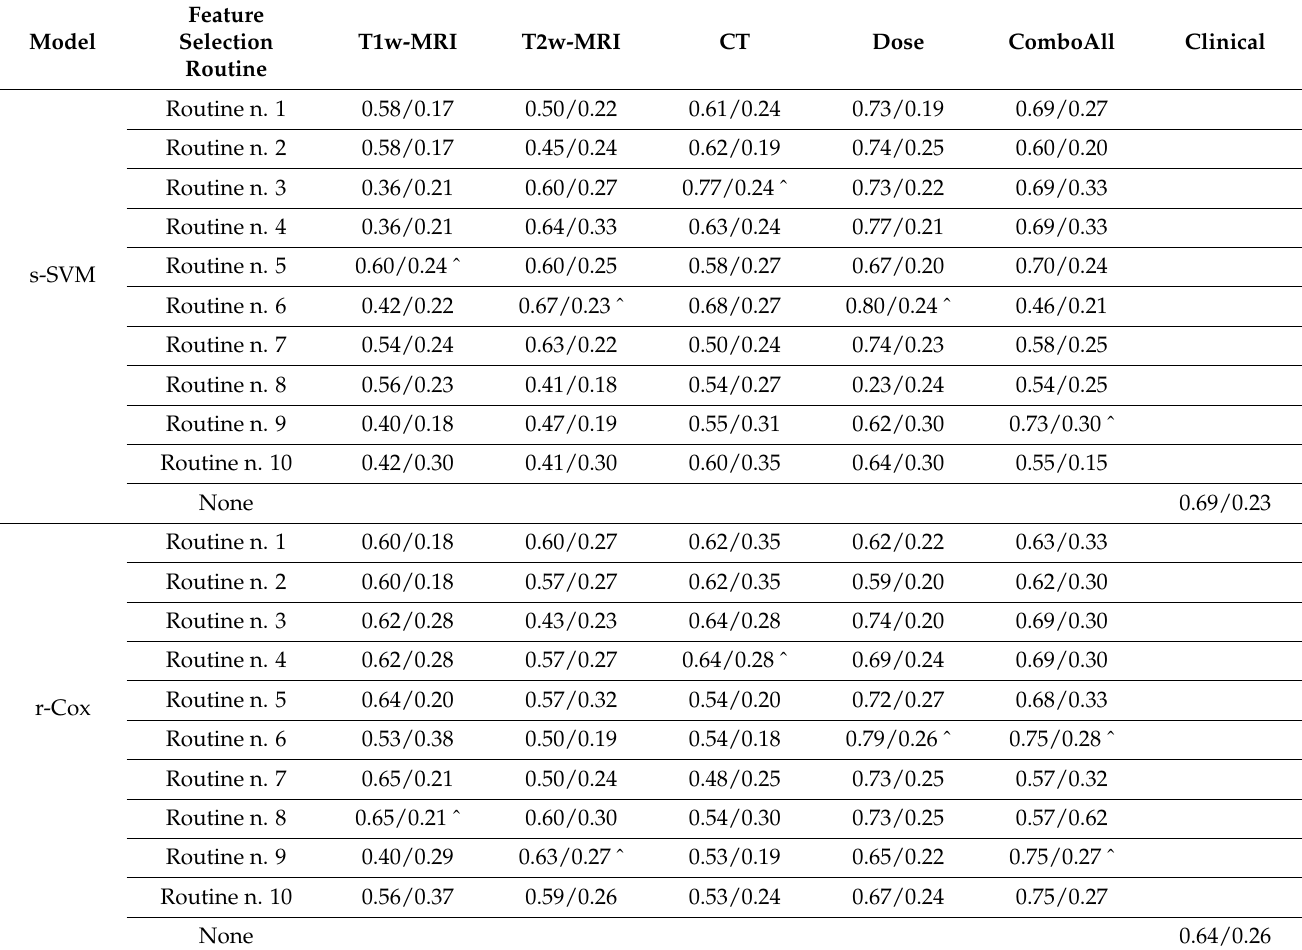
Table 2. Validation concordance indices (validation C-index) from s-SVM and r-Cox models built over various feature subsets, defined by 10 features selection routines (second column, details are given in supplementary materials Table S4), from single modalities (T1w- and T2w-MRI, CT, dose, clinical) and from a combination of those (comboAll). Values are reported as median/interquartile range. Best cases for each modality are marked with